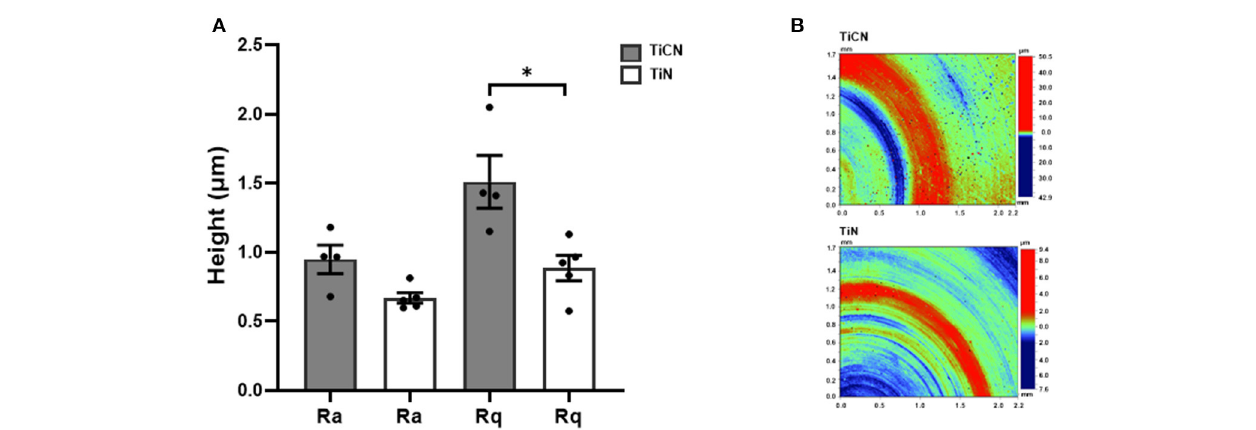
FIGURE 2 | Roughness measurements of TiCN and TiN coatings by white light interferometry. (A) A histogram comparing the Ra (surface roughness average) and Rq (root mean square roughness) values between the two types of coatings. The average Ra and Rq values are shown with standard error of mean. (B) Representative images of TiCN (upper panel) and TiN (lower panel) coating measurements are shown. *indicates significant differences of p < 0.05.